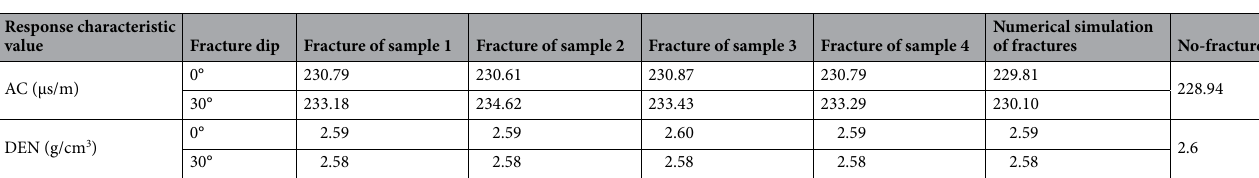
Table 1. The measured response characteristic data of different fractures and non-fractures in the same lithology